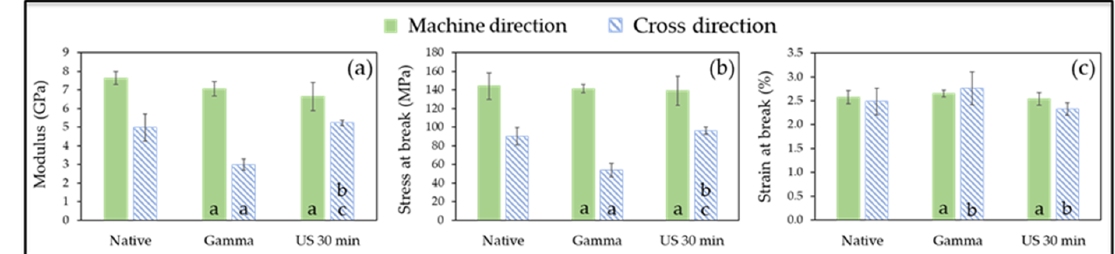
Figure 11. Bending tests results for ( a ) modulus; ( b ) stress at break; ( c ) strain at break ; Gamma column: If value is different compared to Native ( p value < 0.05) letter b; otherwise letter a; US 30 min column: If value is different compared to Native, letter b otherwise letter a. In addition, if value is different compared to Gamma, letter c, otherwise left blank.